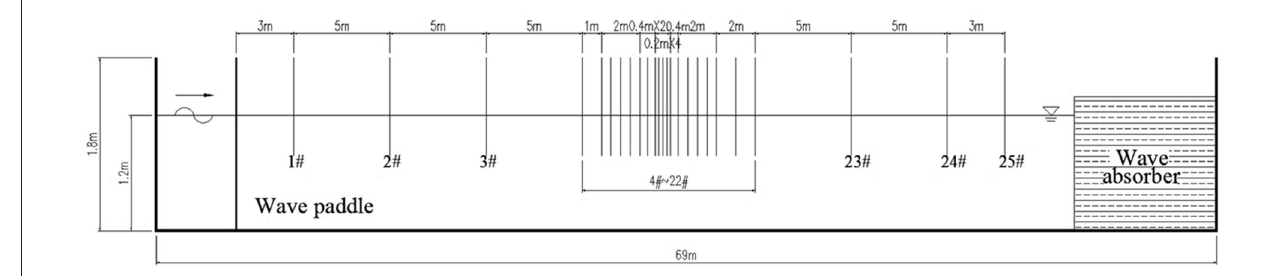
FIGURE 1 | Sketch of the experimental